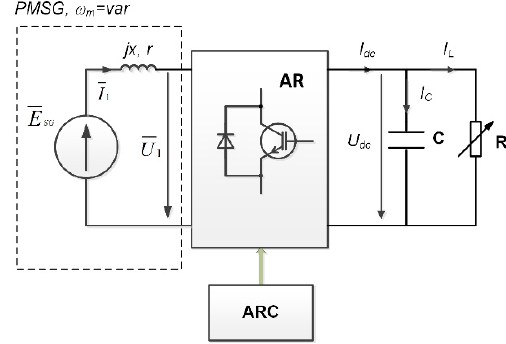
Figure 4. Equivalent circuit of the PMSG–AR mechatronic system.